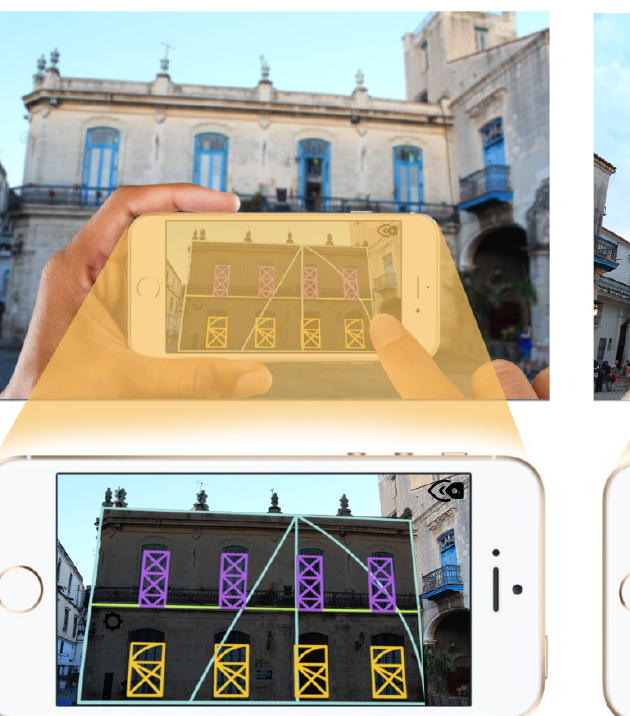
Figure 12. Example of an application of aumented reality (Catedral de la Virgen Maria de la Conceptión Inmaculada - Plaza de la Catedral)